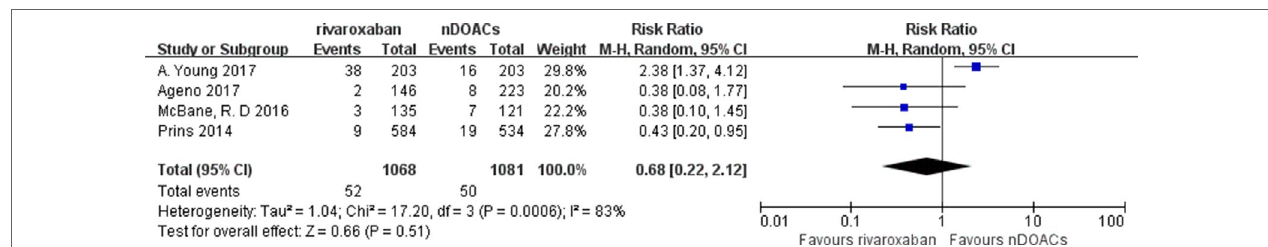
FIGURE 8 | Rivaroxaban MB or CRNMB forest plot.